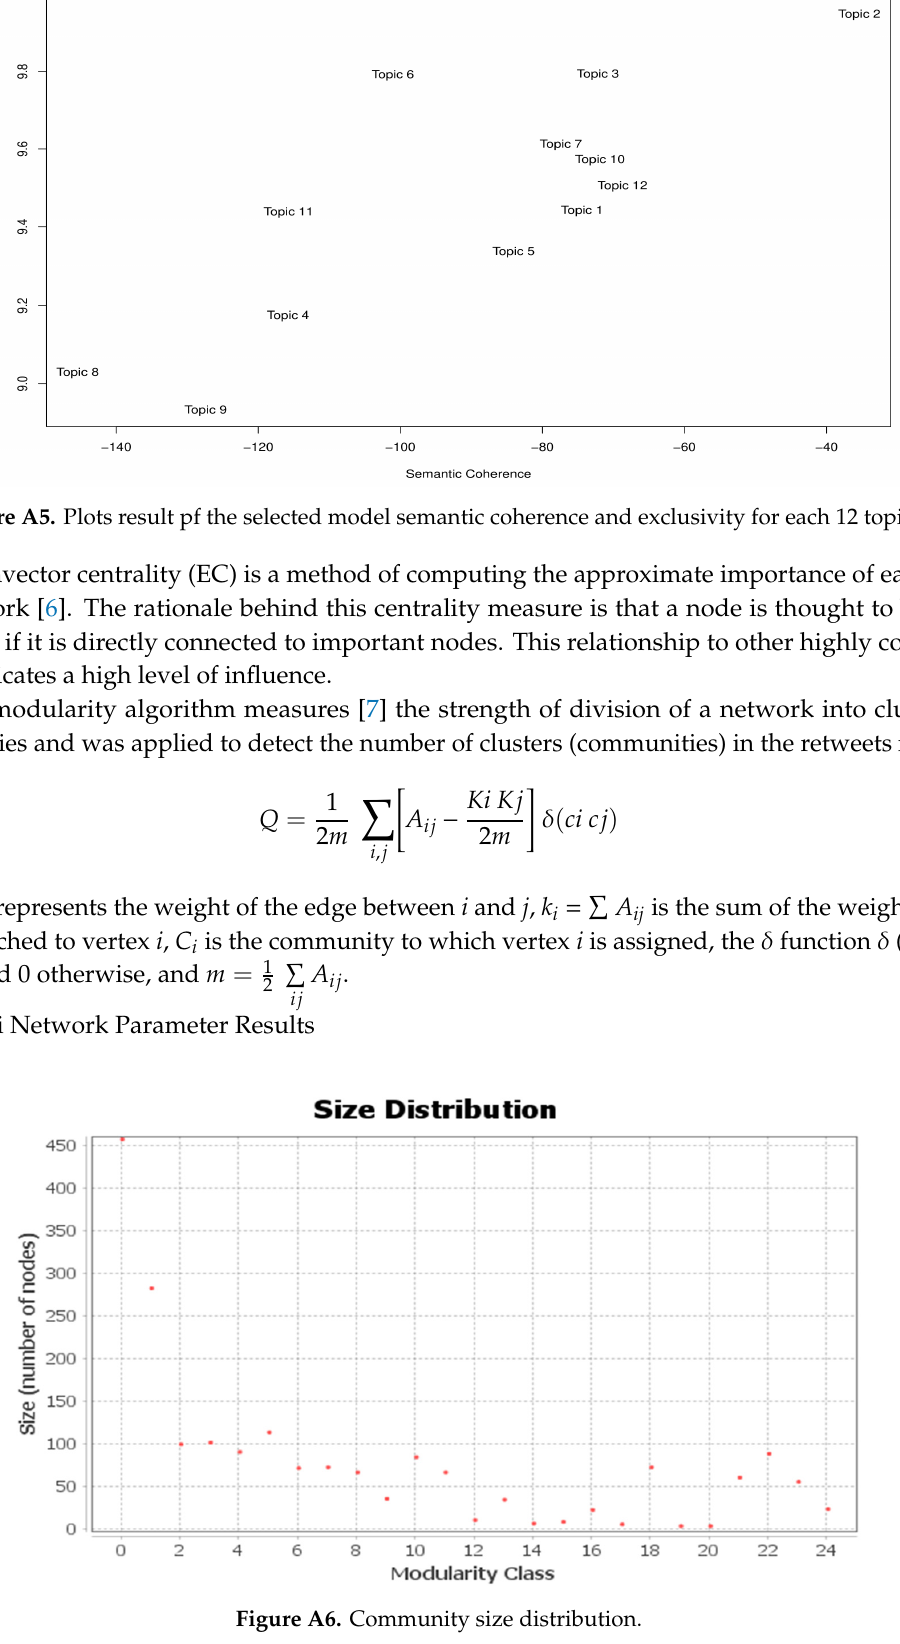
Figure A7. Eigenvector distribution of retweet network data. References 1.